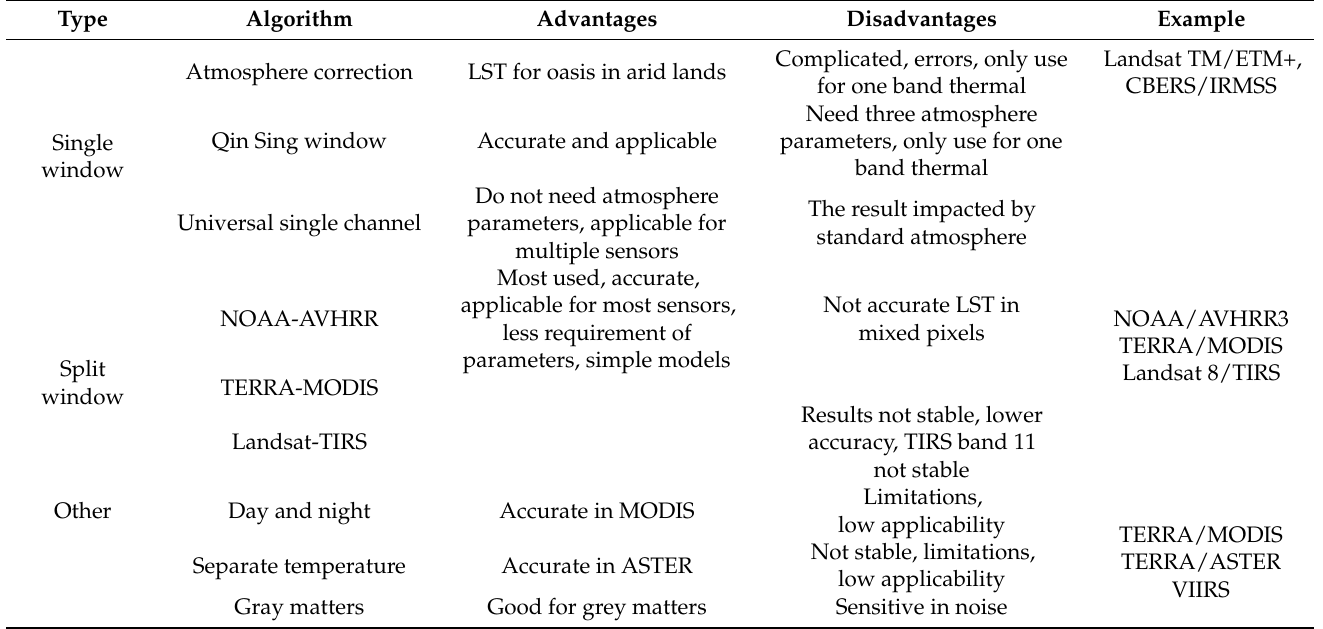
Table 6. Advantages, disadvantages, and applicability of commonly used algorithms for calculating